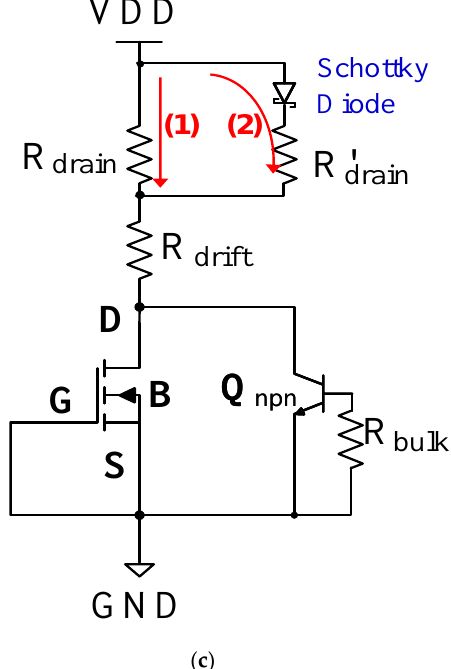
Figure 3. ( a ) 3D structure view, ( b ) layout diagram, and ( c ) equivalent circuit of the HV nLDMOS with the drain electrode-embedded horizontal Schottky elements modulation. Table 1. Area ratios of N + and Schottky diode regions in the drain side. nLDMOS N + Area (%)